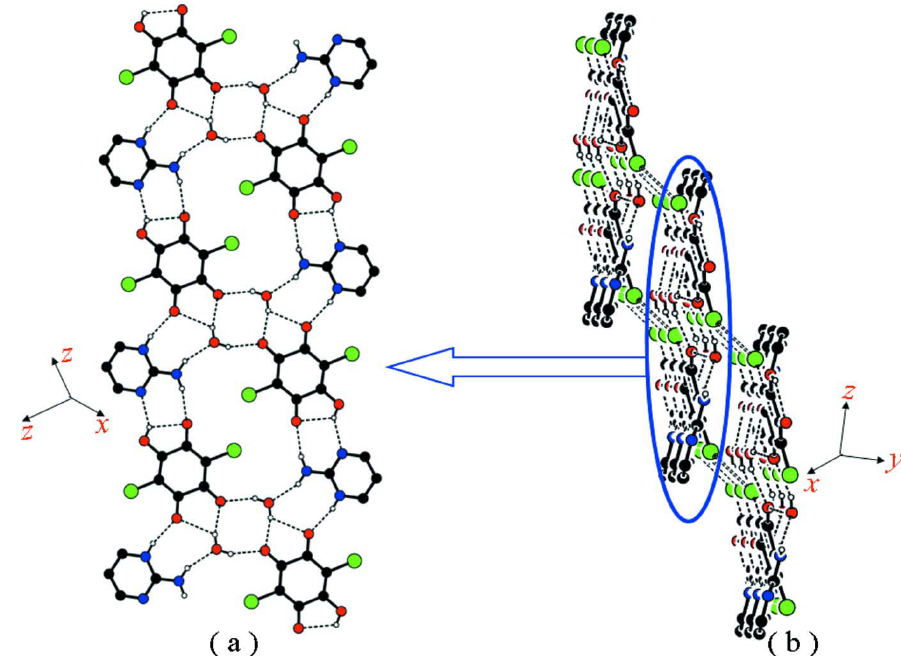
Figure 2 Part of the crystal structure of (I), showing the formation of the one-dimensional tape (a) linked by intermolecular O- H···O and N-H···O hydrogen bonds parallel to the [111] direction and the two-dimensional sheet (b) linked by Cl···Cl interactin. For the sake of clarity, H atoms not involved in the motif have been omitted from the